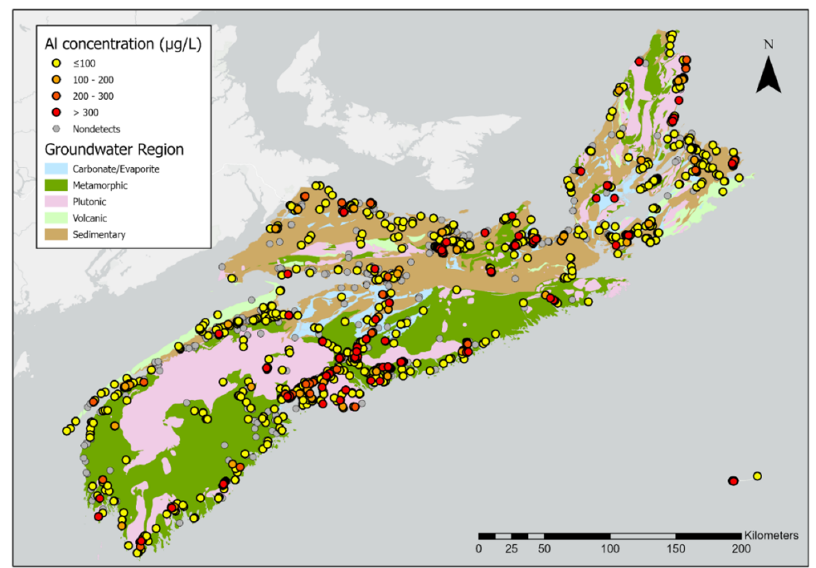
Figure 3. Aluminum concentrations in water wells compared to the bedrock groundwater regions of Nova Scotia.